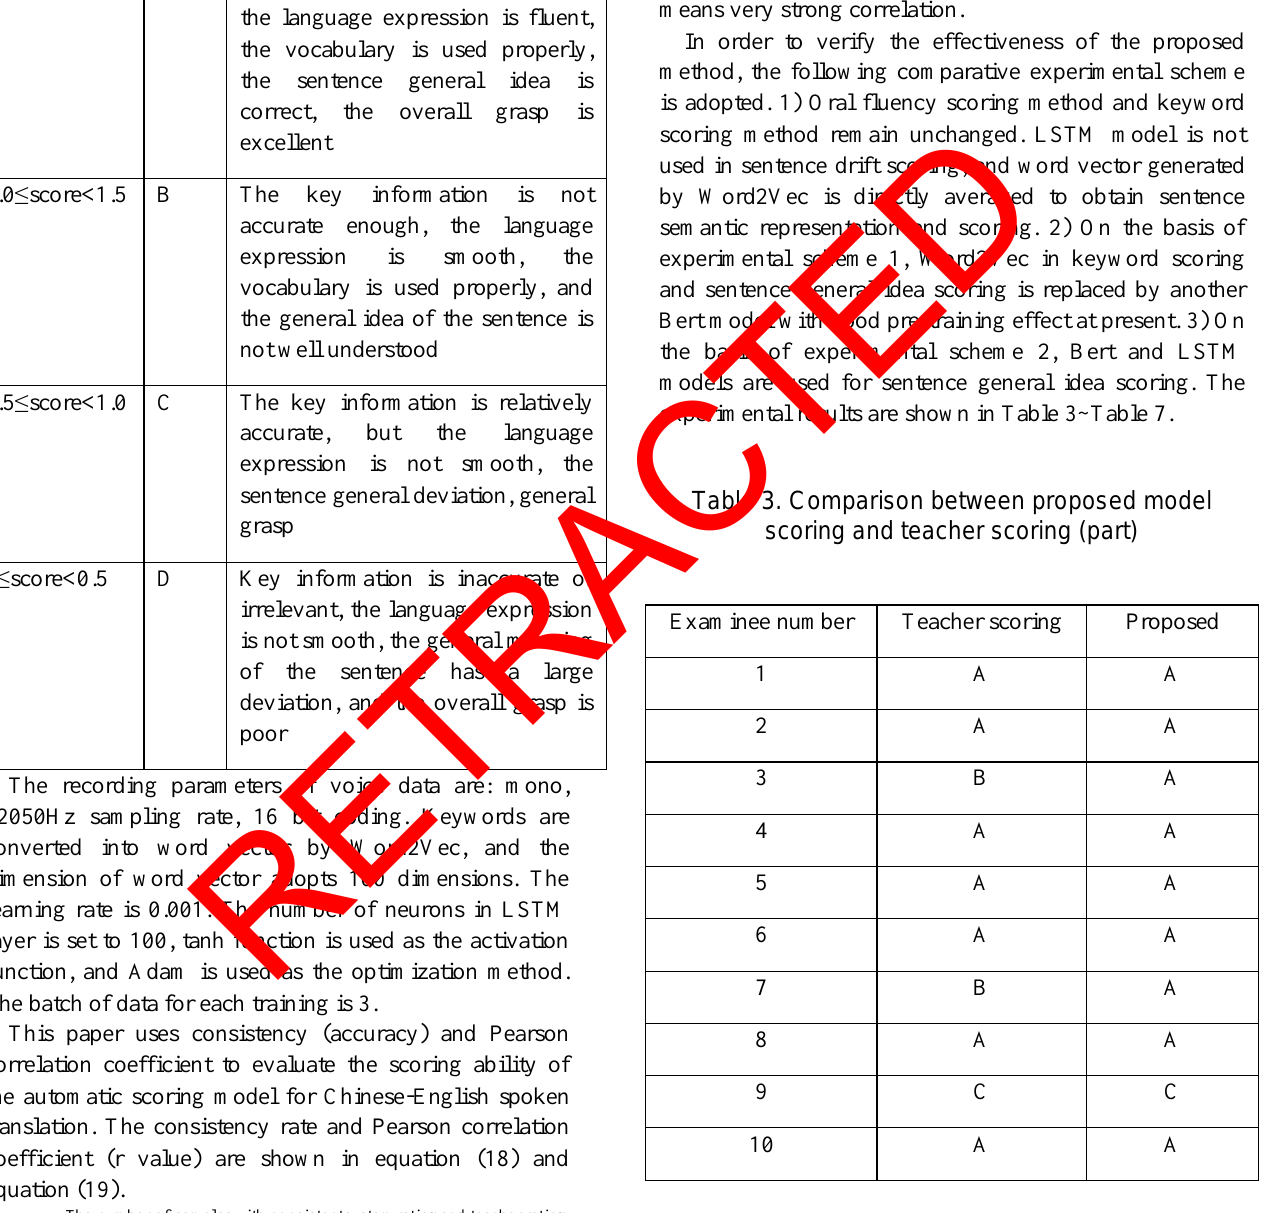
Table 4. The consistency between the new